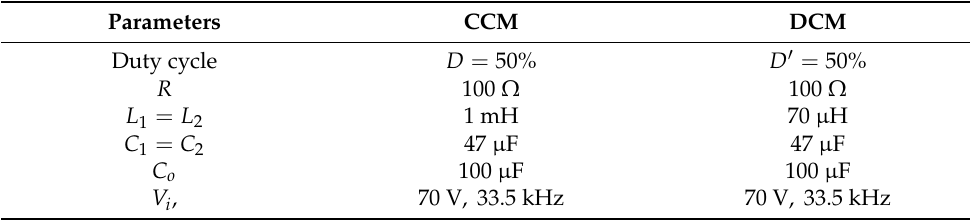
Table 3. Parameters for the proposed converter